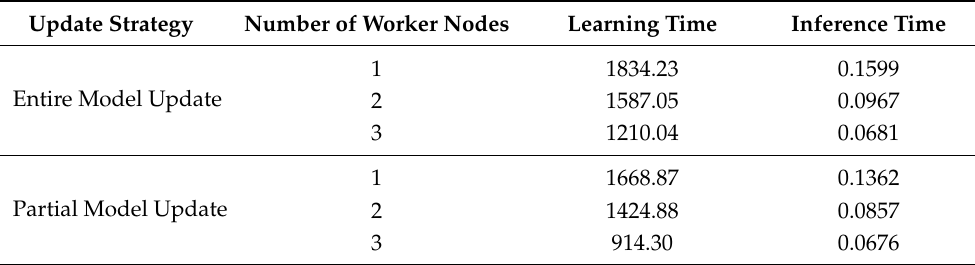
Table 6. The elapsed time for training model by the number of worker nodes using proposed strategies